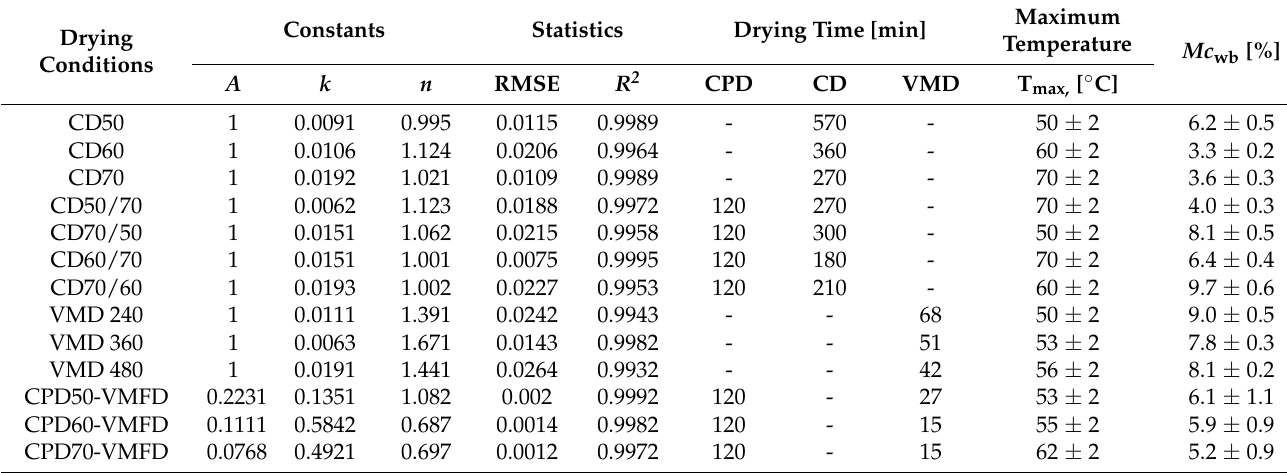
Figure 1. Drying kinetics of cilantro obtained by ( a ) convective drying at 50, 60 and 70 °C; ( b ) convective pre-drying for 120 min at 50, 60 and 70 °C followed by convective finishing drying; ( c ) vacuum-microwave drying at 240, 360 and 480 W; ( d ) combined convective pre-drying at 50, 60 and 70 °C followed by vacuum-microwave finishing drying at 360 W—results presented for VMFD part of the treatment. Table 2. Model constants ( A, k, n ), drying times, maximum temperature (T max ), and final moisture content (Mc wb ) of the cilantro samples dried using different methods.